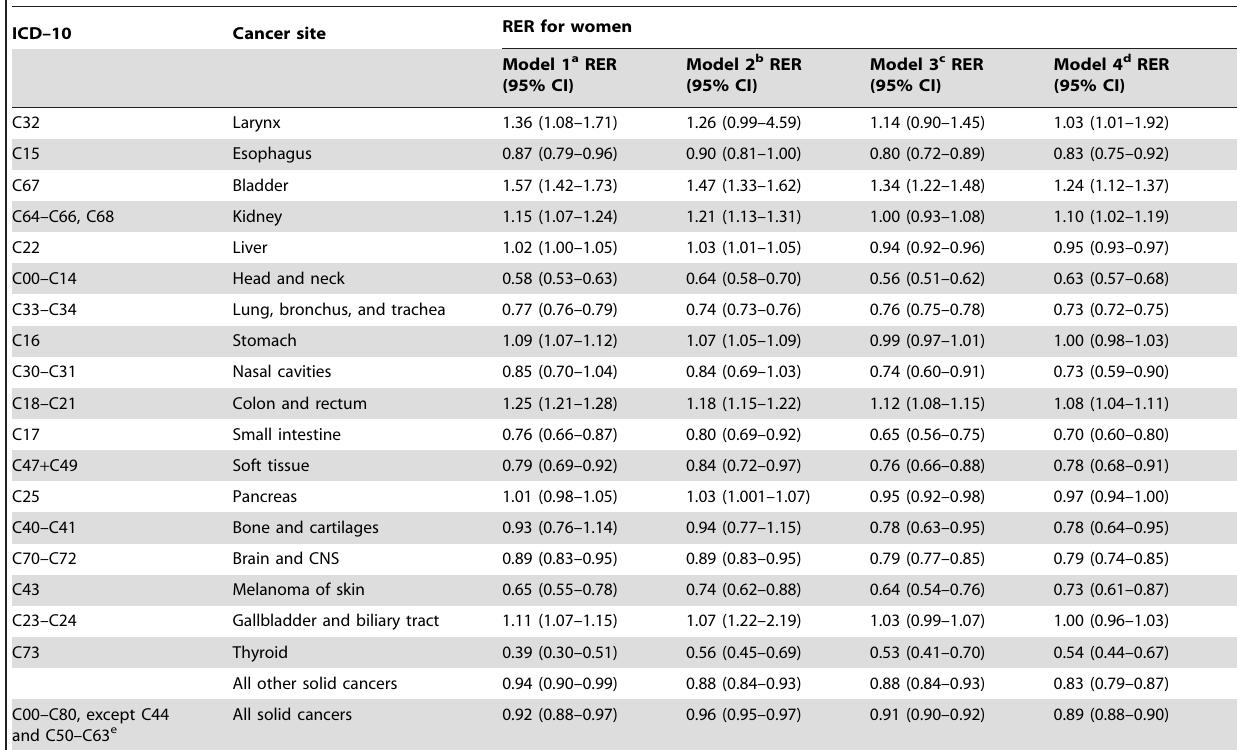
Table 2. Relative excess risk (RER) for solid cancer sites among Korean adults,